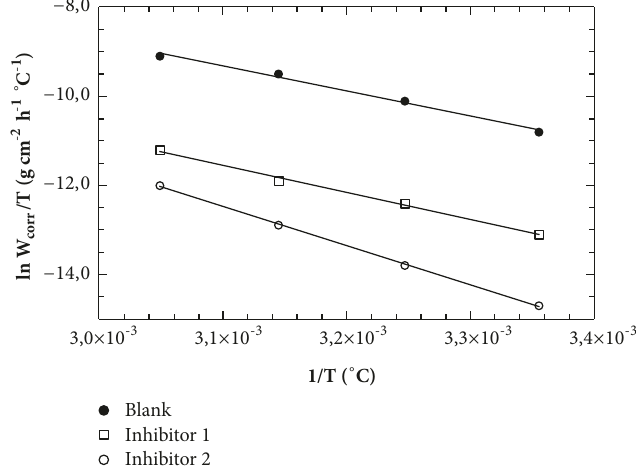
Figure 4: Adsorption heat ( (cid:2) 𝐻 0 ) and adsorption free entropy ( (cid:2) 𝑆 0 ) of triazole compounds on the carbon steel surface in 1.0mol L – 1 HCl aqueous